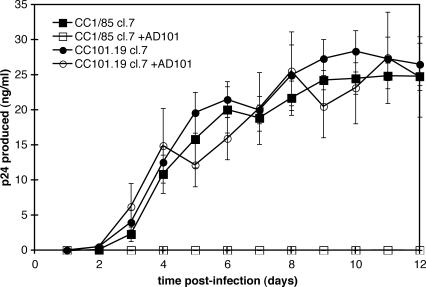
Replication Kinetics of Clonal, Env-Chimeric Viruses with an AD101-Sensitive or an AD101-Resistant env GeneThe amount of p24 produced from PBMC culture infected with equal titers of CC1/85 cl.7 (squares) or CC101.19 cl.7 (circles), in the absence (filled symbols) or presence (open symbols) of 1 μM AD101, was determined at the indicated time points. Duplicate wells were used to derive each experimental value in each experiment, and the data shown are the average ± standard error of the mean (SEM) of values from five independent experiments.